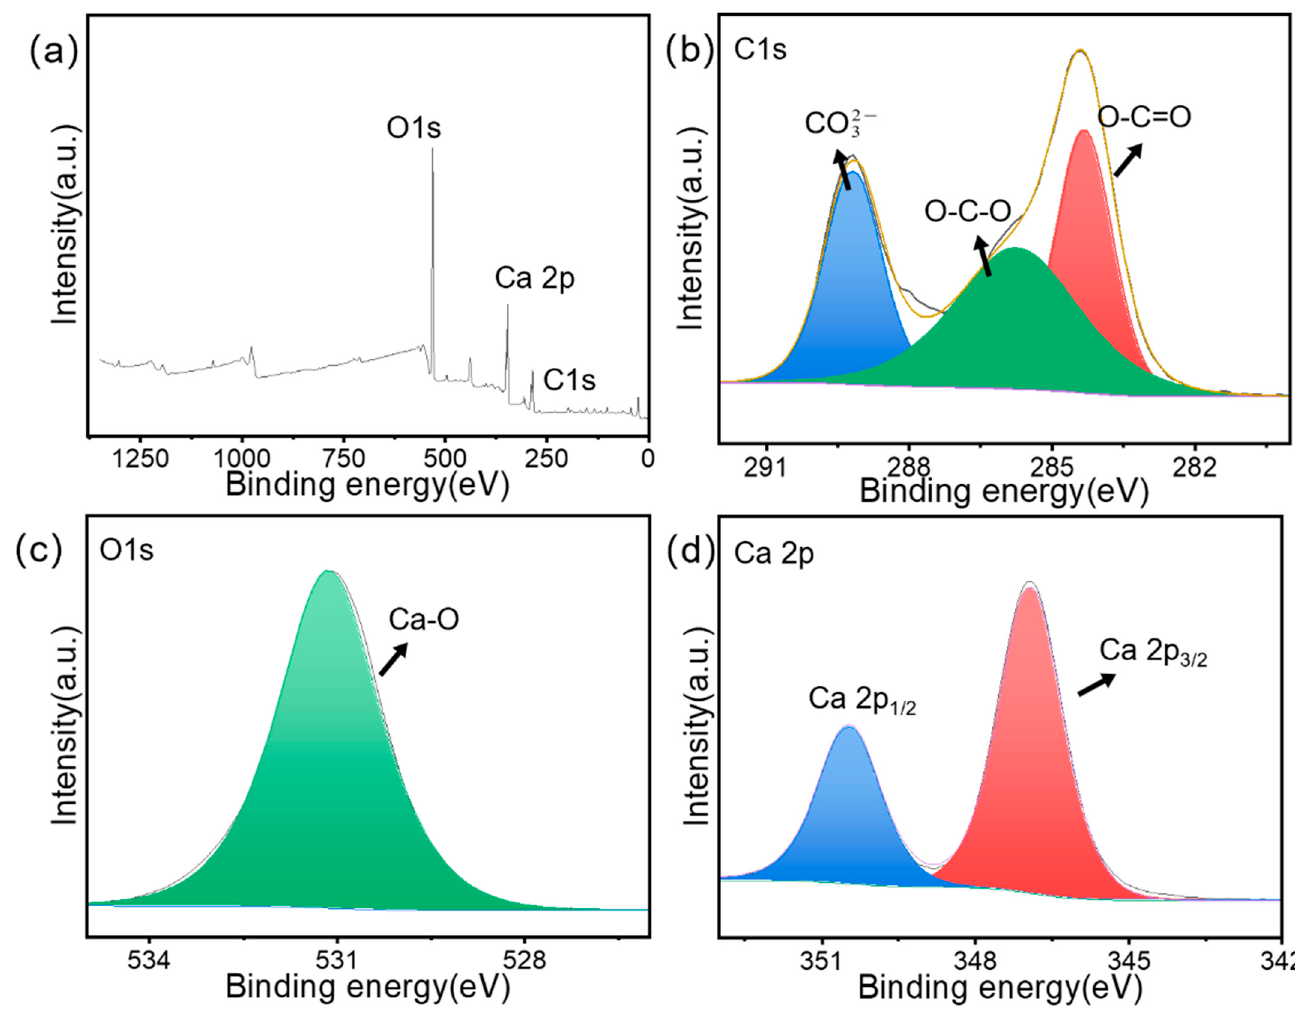
Figure 8. XPS full spectra of ( a ) raw snail shells, ( b ) C 1s, ( c ) O 1s, and ( d ) Ca 2p.